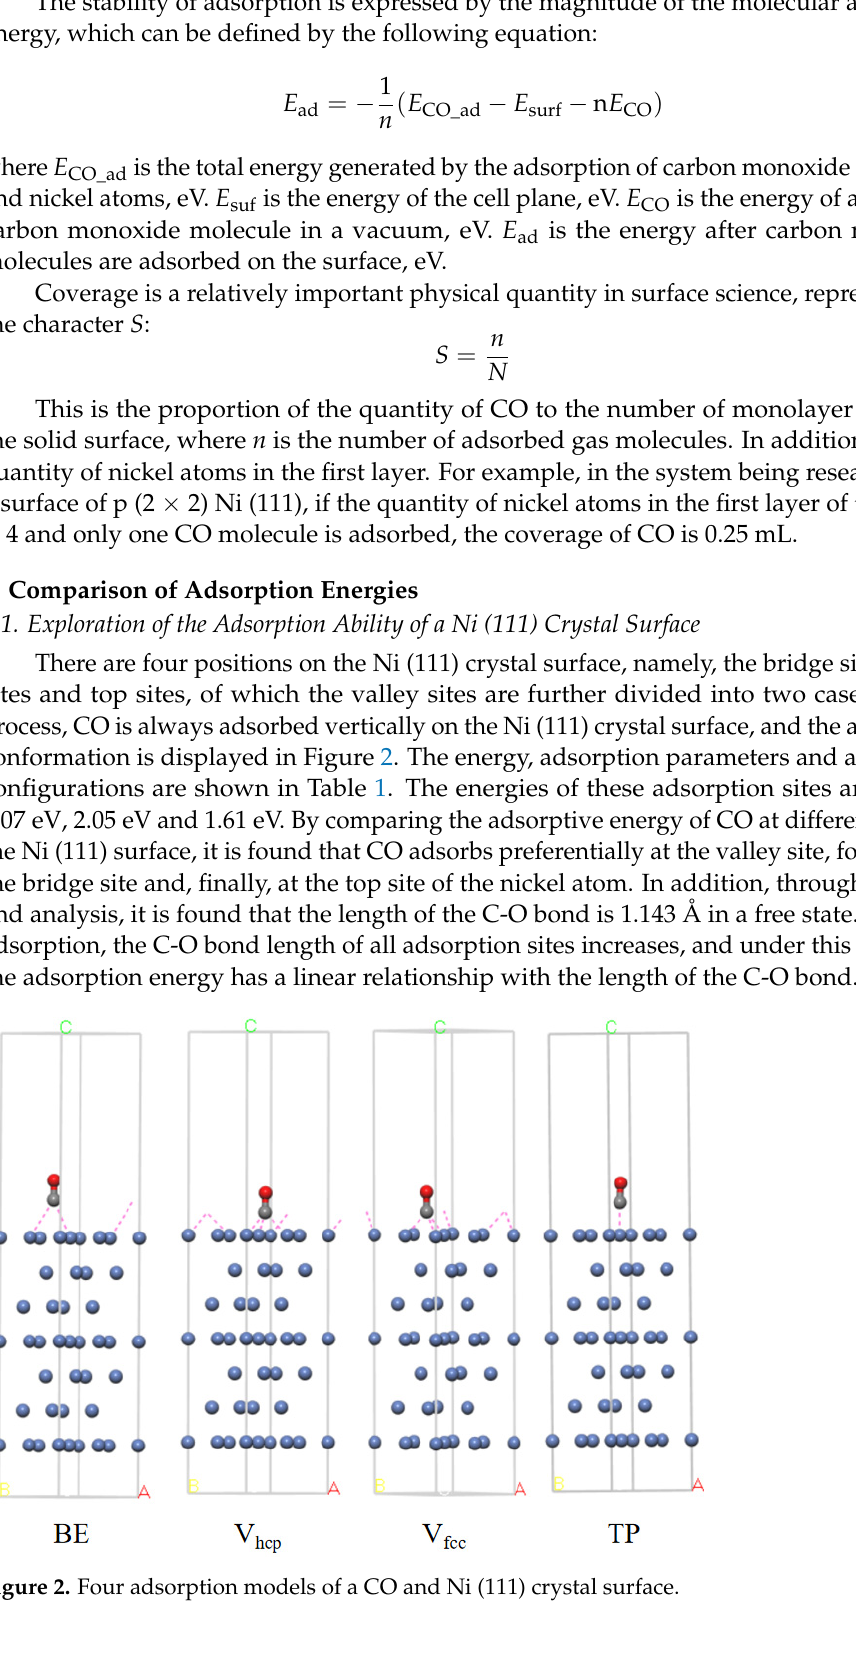
There are three adsorption positions, including the bridge site, valley site and top site. The adsorptive configurations are shown in Figure 3, and the relevant data are shown in Tables 1 and 2. The data statistics and comparisons show that the Ni-C bond length is roughly distributed at 2.04 Å when CO is preferentially adsorbed at the valley site. Com- pared with the free state, the increasing length of the C-O bond length is 0.07 Å. This shows that when CO is at the valley sites of the Ni (100) surface it has a significant effect on the activation of CO. In addition, by analyzing the data, we can draw the conclusion that the adsorption energy of CO is weaker on the Ni (111) surface than on the Ni (100) surface at the corresponding position without changing the calculated parameters.